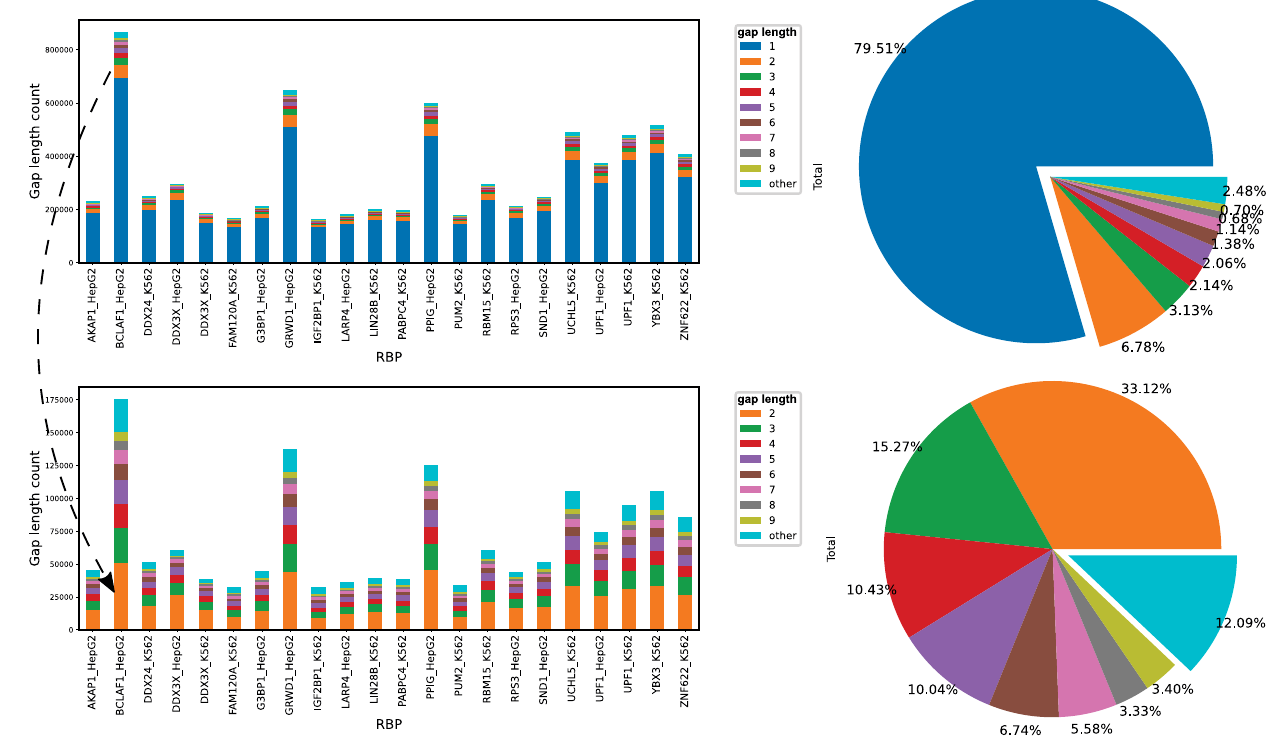
Fig 3. Distribution of gap lengths among base-pairings for individual